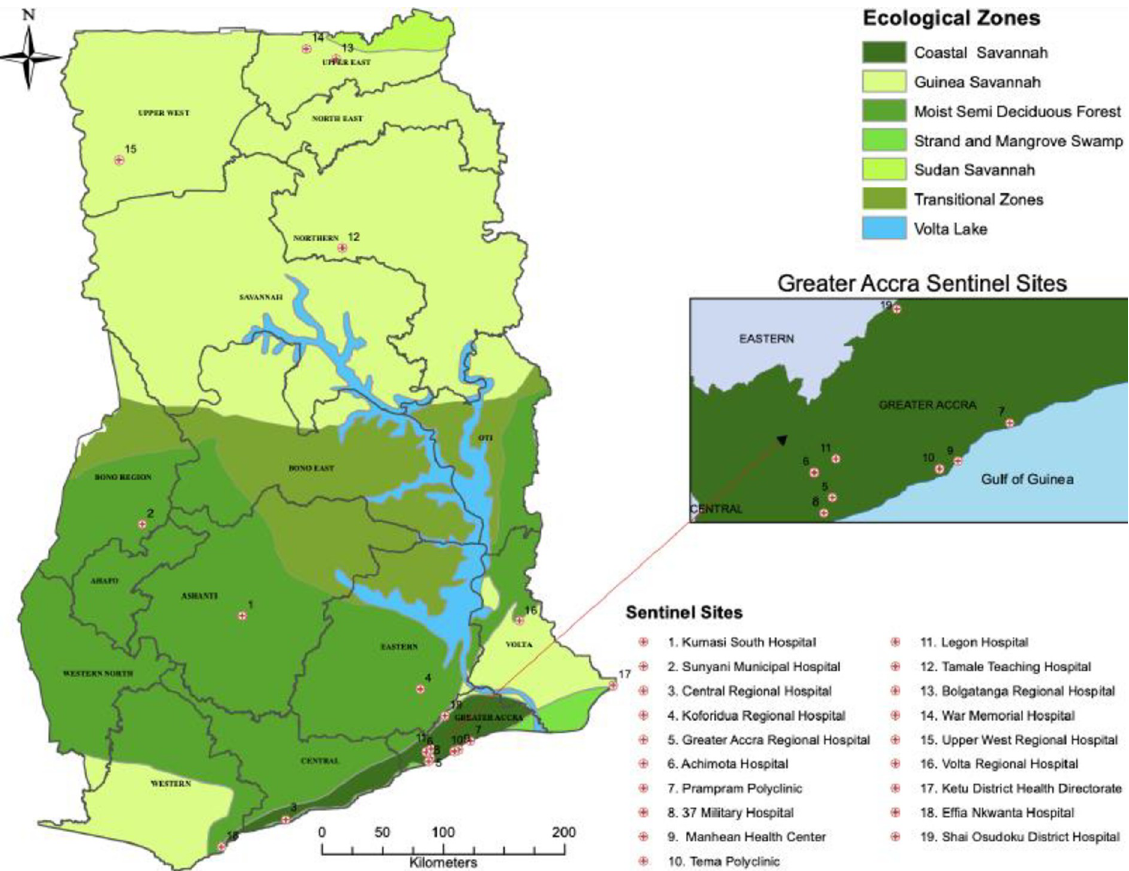
Fig 1. Map of Ghana showing selected influenza sentinel sites located throughout the country. Also shown are the ecological variations of the country. Southern Ghana is green with semi-arid conditions, while Northern Ghana is dry and hot. Southern Ghana is densely populated (Accra-2,291,352) while population density in Northern Ghana is low (562,919-Tamale, Northern Region). Note: Only 19/31 sentinel sites are identified. Those located on Ghana Armed Forces military sites, with the exception of 37 Military Hospital, are not depicted for security reasons. The map was obtained from Centre for Remote Sensing and Geographical Information Services (CERSGIS). This was created using ESRI ArcMap version 10.8 with the boundaries obtained from Ghana Statistical Service (GSS).